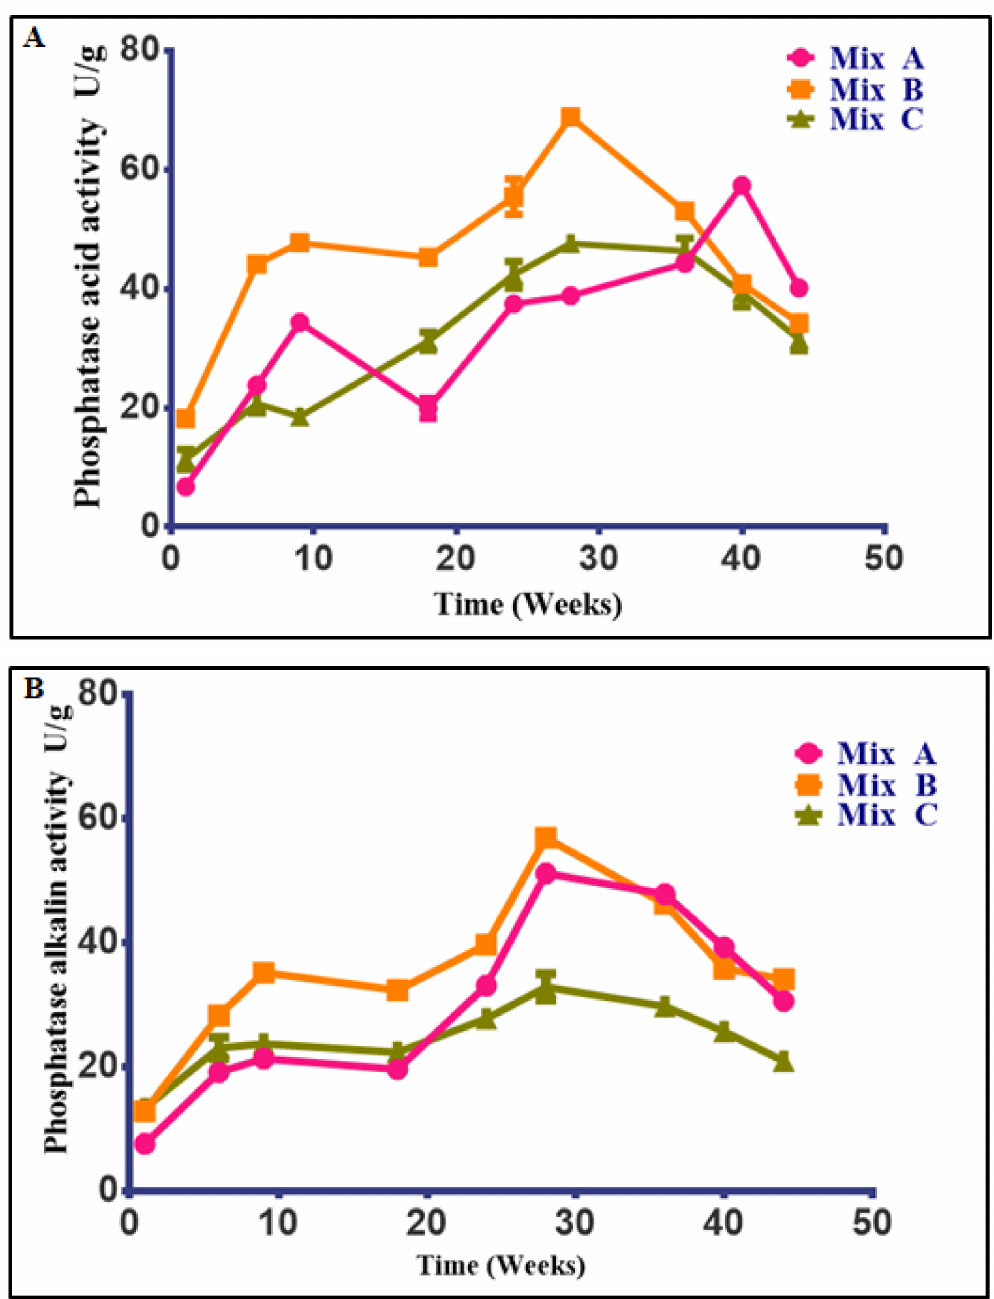
Figure 8. Changesinphosphatase(acid( A ),alkaline( B